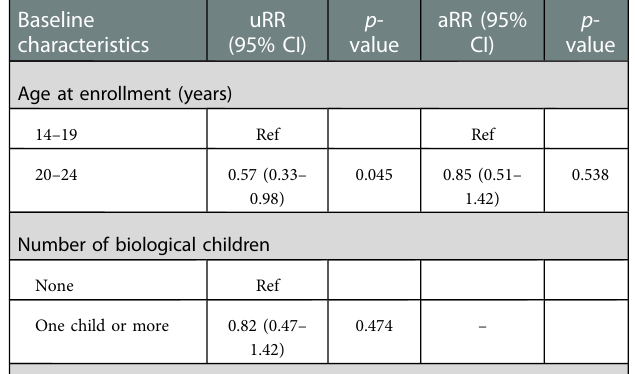
TABLE 2 Baseline factors associated with becoming pregnant among adolescent girls and young women in Kampala, Uganda. Baseline